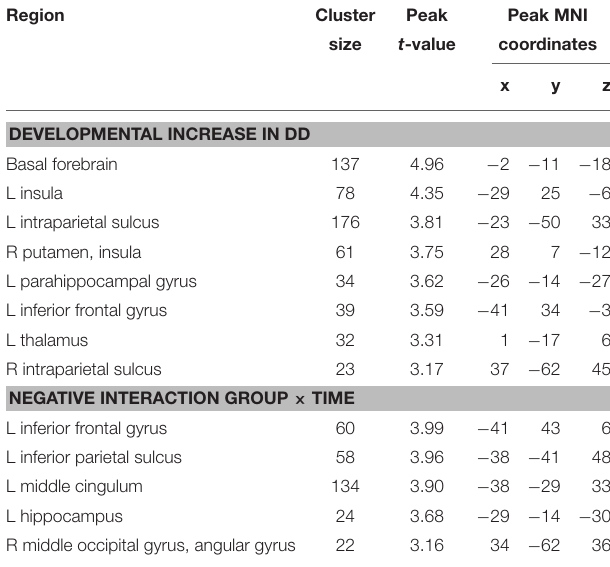
TABLE 6 | Brain areas that showed significant developmental changes in children with developmental dyscalculia and the negative interaction group by time ( p < 0.005, k ≥ 22, cluster-extend